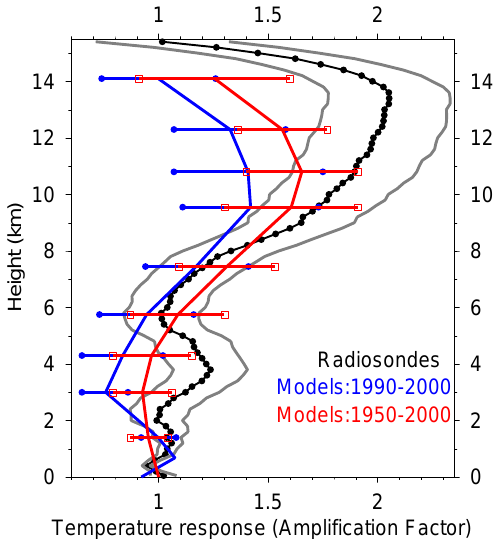
Fig. 10. The black solid curve shows the average lapse rate of the five radiosonde stations during the 10 yr period (1999–2008), as previously shown in Figure 3. Gray curves refer to mean lapse rates of particular models.